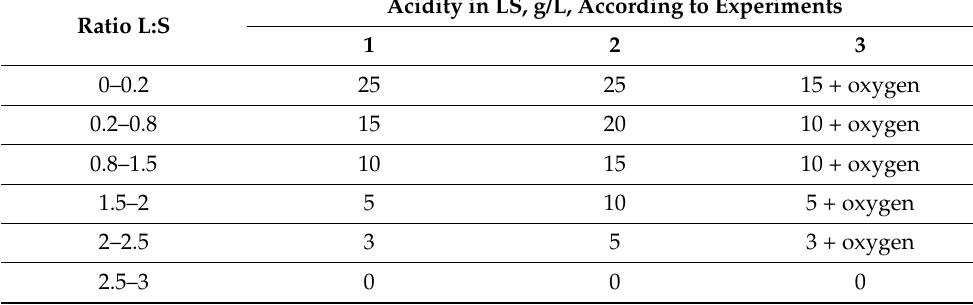
Table 4. Parameters of acidity of